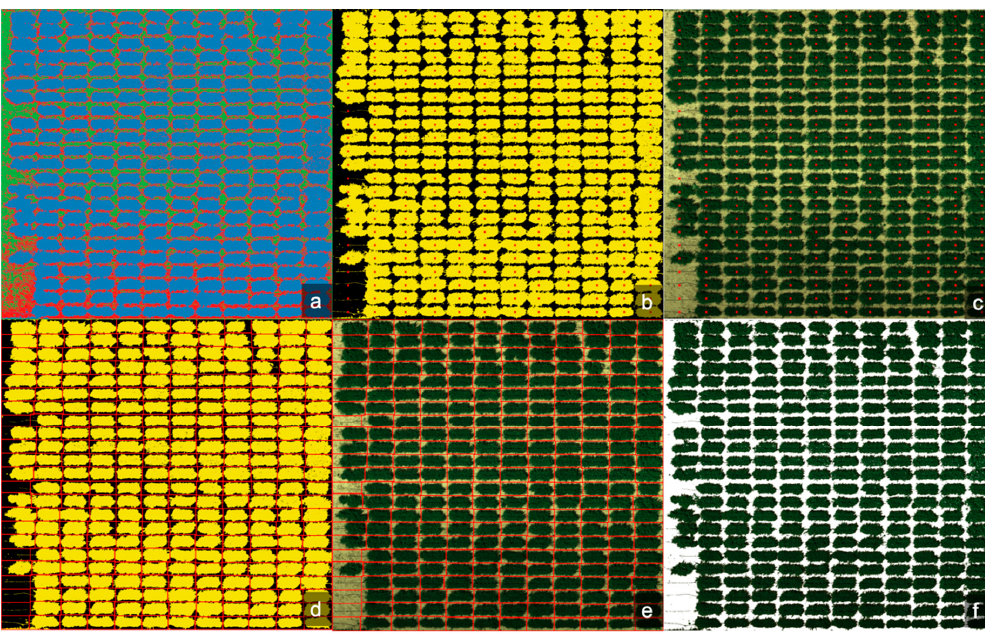
Figure 6. Multiple intermediate images of segmentation. GRID saves multiple intermediate images for documentation, diagnosis, and further image analyses. These intermediate images demonstrate the pixel-wise cluster analysis ( a ), the plot centers on selected pixels of interest ( b ), and the raw image ( c ). The plot boundaries are displayed on both selected pixels of interest ( d ) and the raw image ( e ). The pixels of interest are displayed for the raw image with pixels of non-interest displayed as white background ( f ), which are also saved as HDF5 for each of segmented plots as numpy arrays. The raw image was taken by drone on the alfalfa field in Figure 5.